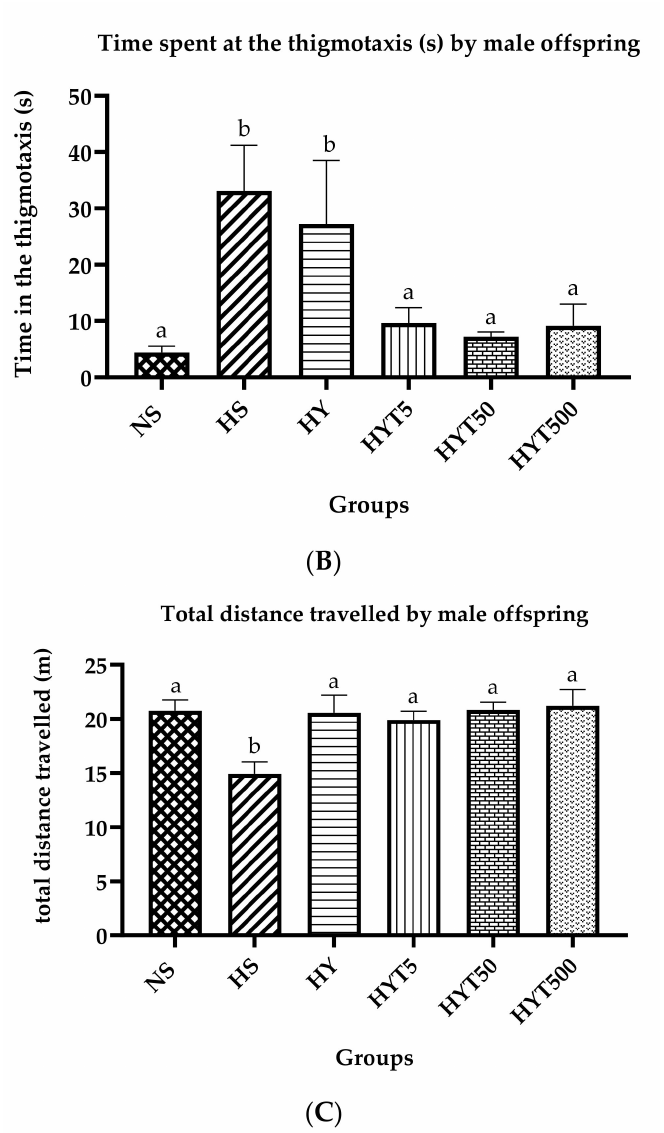
Figure 3. ( A ). Time spent at the central zone by male offspring in an open field test. ( B ). Time spent at thigmotaxis by male offspring in an open field test. ( C ). Total distance travelled in the central zone by male offspring in an open field test. Different letters indicates a significant difference at p <